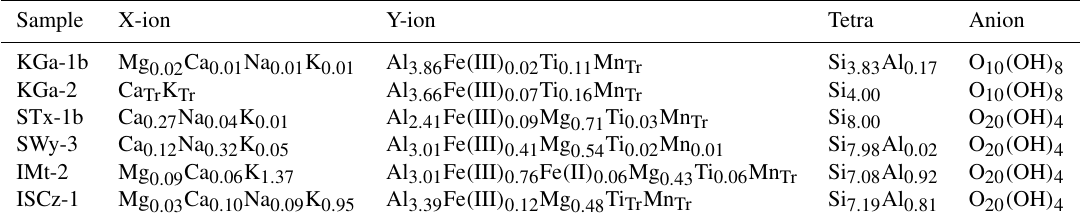
Table 2. Structural formulae of source clays from the Clay Minerals Society calculated from elemental analysis (Mermut and Cano, 2001). Sample